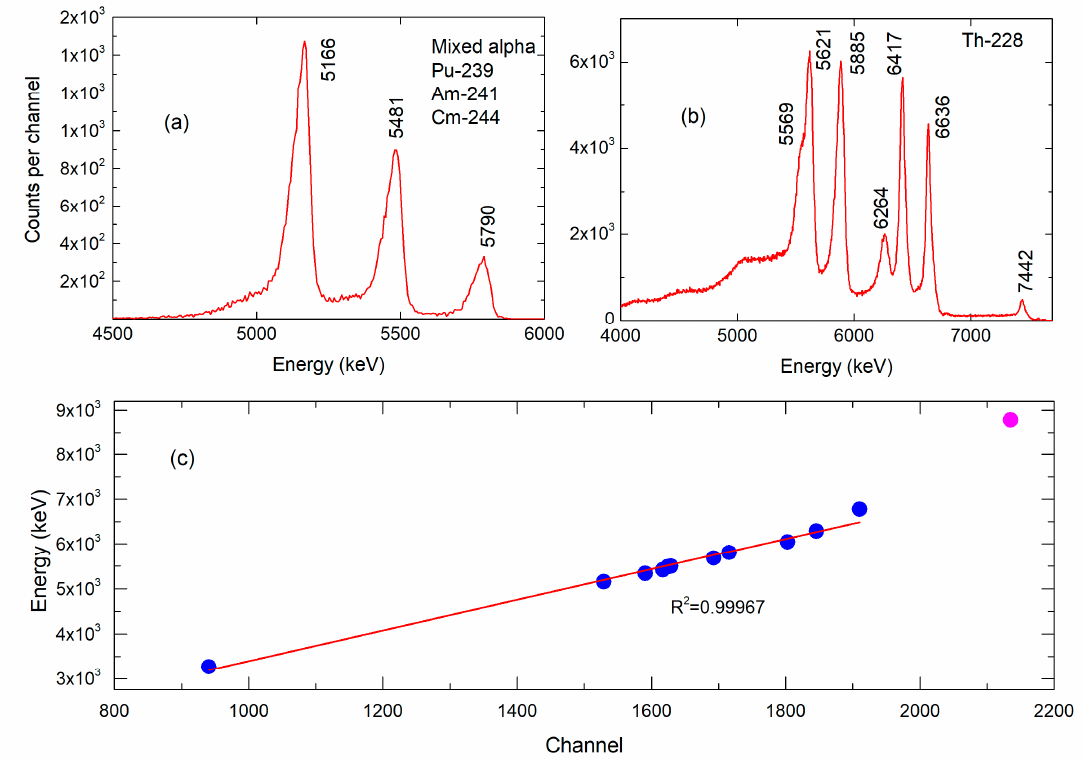
Figure 6. ( a ) Response of the 4H ‐ SiC detector with active surface area of 2 × 2 mm 2 to mixed alpha particle source (Pu ‐